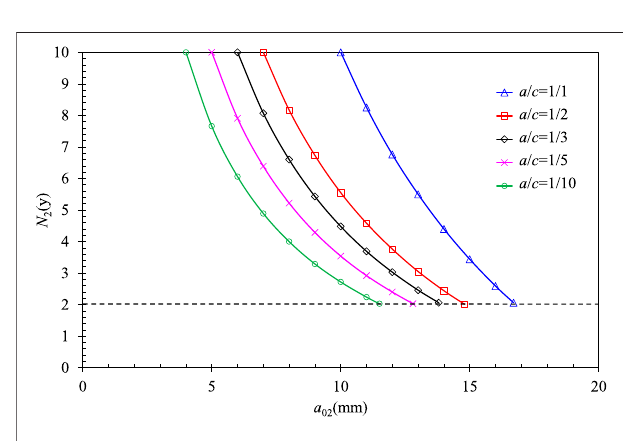
FIGURE 9 | Residual service lifes of different crack aspect ratios for underclad semi-elliptical cracks in RPV cylinders.